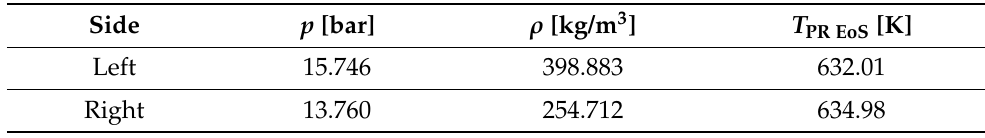
Table 3. Shock tube. Setup for shock tube case [4]. Temperatures T PR EoS are computed with Peng– Robinson EoS.